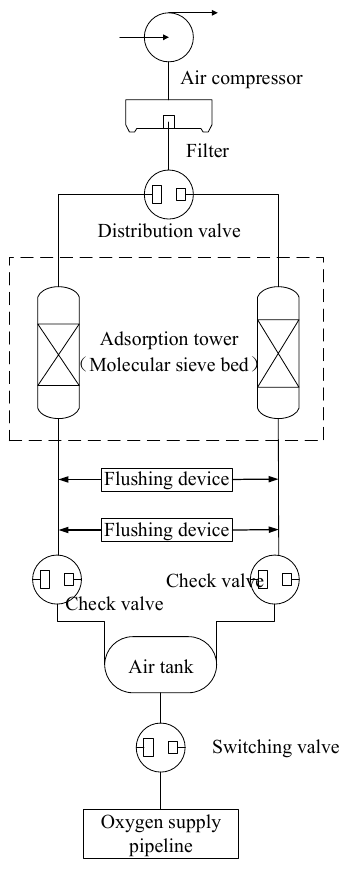
Figure 1. Molecular sieve oxygen-production system workflow.